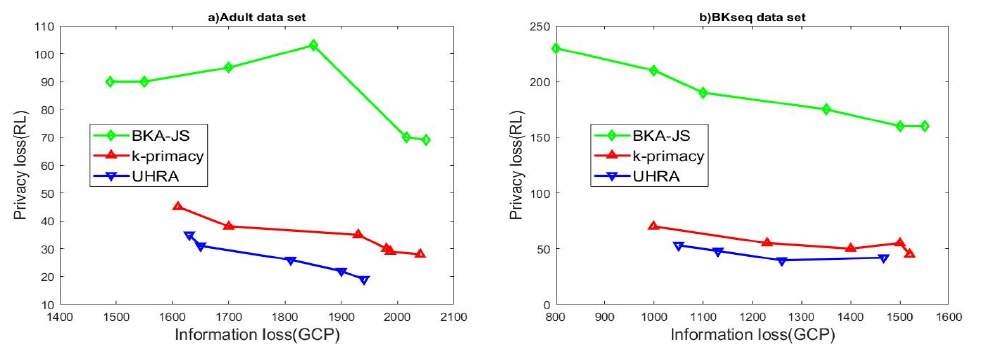
Figure 1. R-U Map regarding various k values.